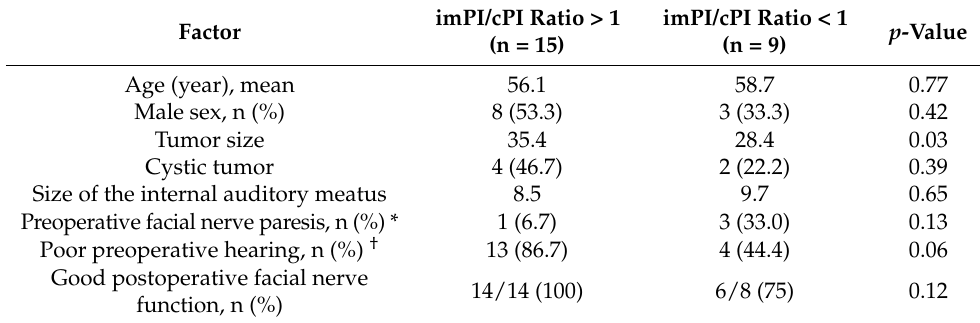
Table 3. Univariate analysis of patterns of proliferation index associated with clinical and radiological features (n = 24).